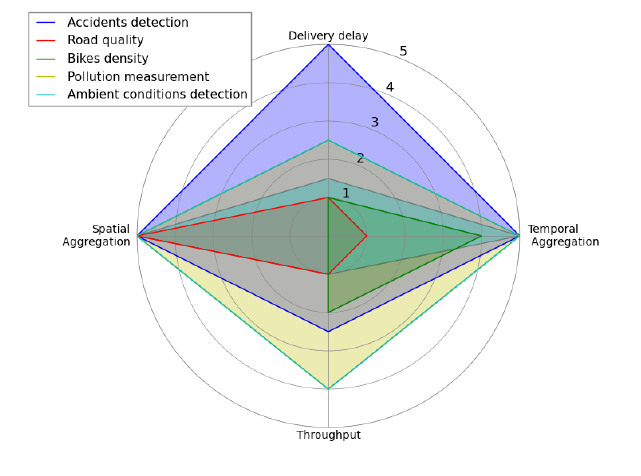
Figure 47. Performance comparison between five